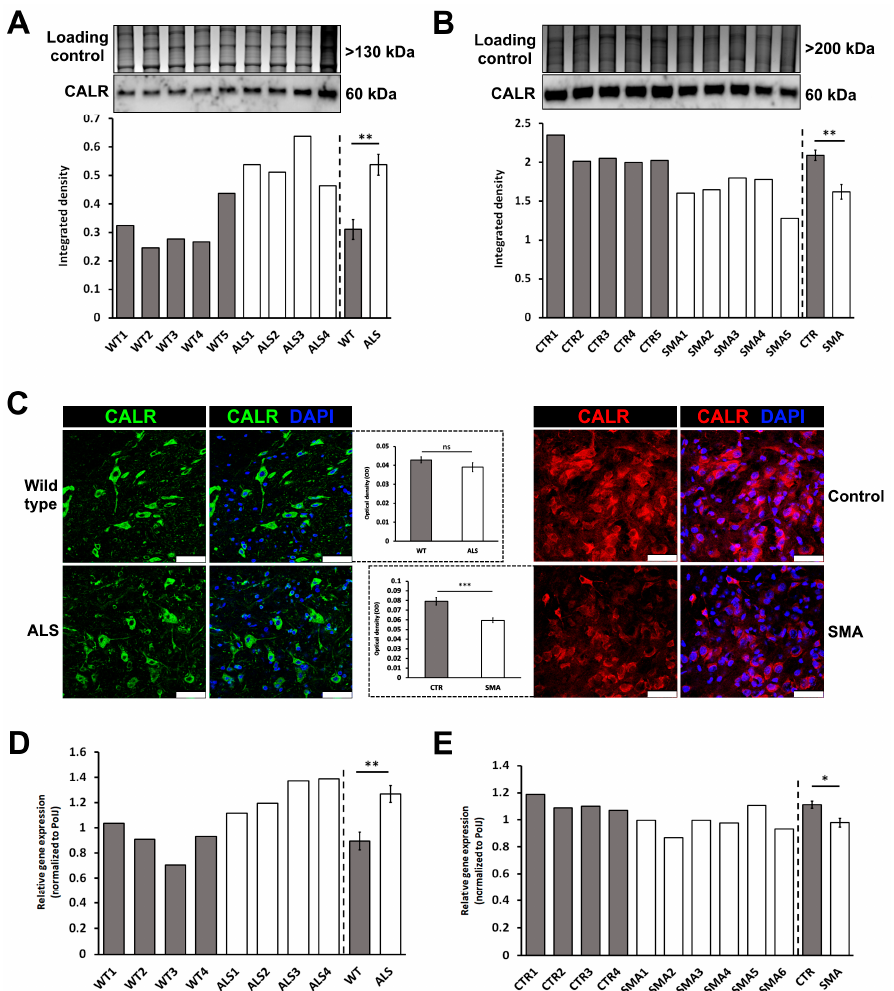
Figure 5. Dysregulated expression of calreticulin in spinal cord extracts from late-symptomatic ALS mice (20 week) and late-symptomatic SMA mice (P8). Representative western blots showing ( A ) a 43% increase in calreticulin (CALR) expression levels in spinal cords of ALS mice ( n = 4) compared to wild type (WT) mice ( n = 5); ( B ) a 26% reduction of calreticulin expression in SMA mice ( n = 5) compared to control mice ( n = 5). Graphs are presented as integrated density of measured protein normalized to total protein (Coomassie stained gel). Densitometry measurements for individual samples and mean of the group are shown, with error bars showing standard error from the mean; ( C ) Representative immunohistochemistry images showing calreticulin expression in the ventral horn of lumbar spinal cord sections in 20-week-old WT and ALS mice and in control and age-matched (P8) SMA mice. Scale bar = 50 µ m. Densitometry measurements of calreticulin levels in alpha motor neurons are presented as mean optical density, with error bars showing standard error from the mean. ( D ) Calreticulin gene expression levels in WT and ALS mice, and; ( E ) in control and SMA mice, as determined by RT-PCR. Expression levels of calreticulin were normalized to PolJ . Error bars represent standard error from the mean. CALR—Calreticulin; CTR—Control; WT—Wild Type. ns—Not Significant; * p < 0.05; ** p < 0.01; *** p <